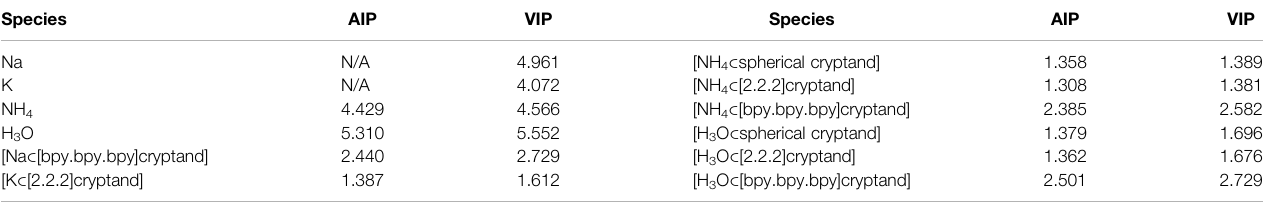
TABLE 2 | Values of VIP and AIP [eV] obtained at MP2/ Basis-1 level of theory. Species AIP VIP Species Na